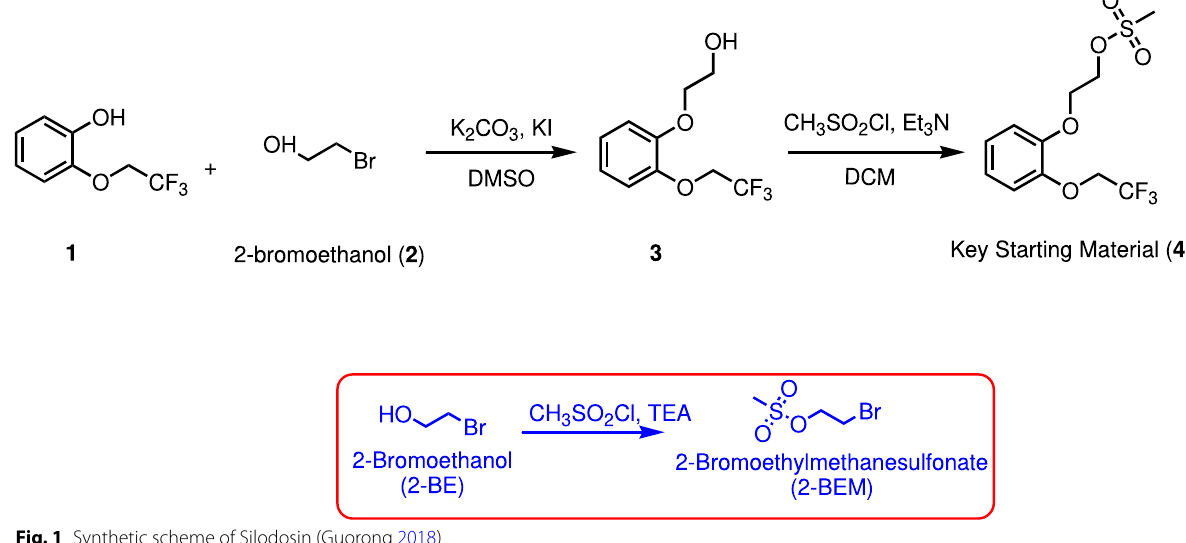
Fig. 1 Synthetic scheme of Silodosin (Guorong